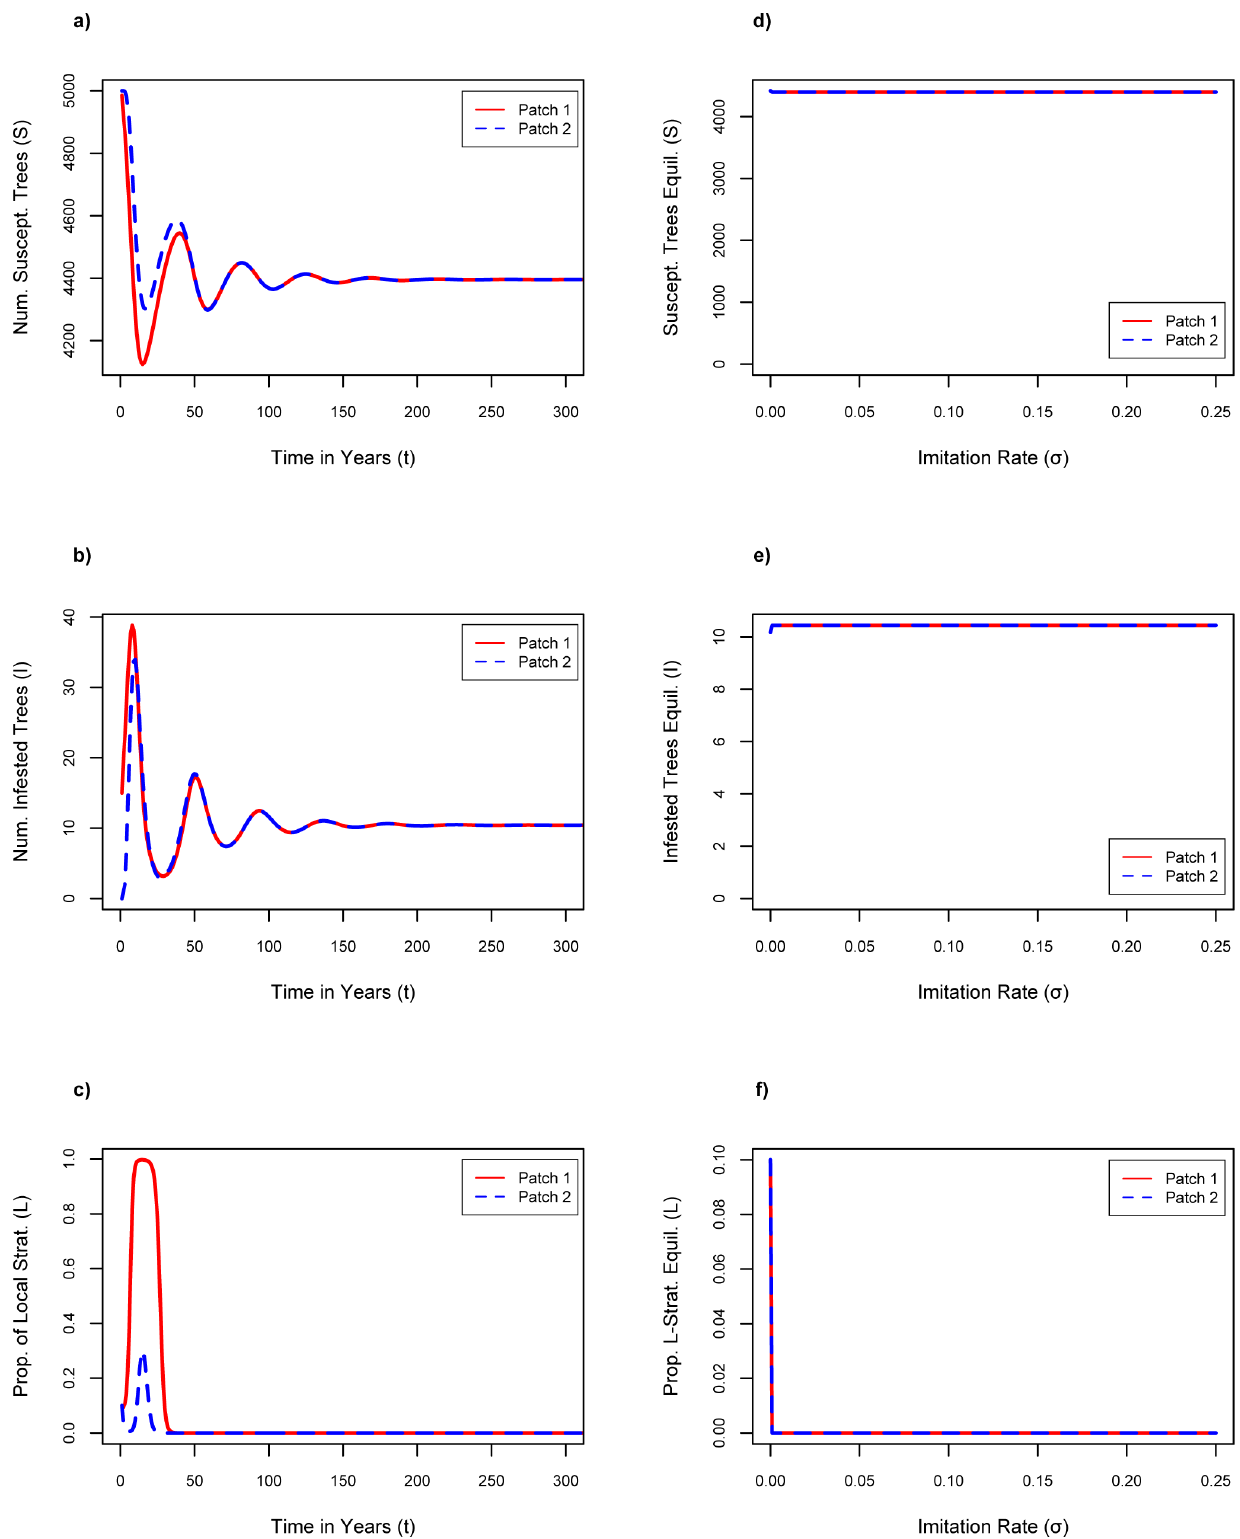
Figure 3. Results of increasing imitation rate. Increase imitation rate: n=0.1, f=0.1, Cl= $ 6.75 where a) number of susceptible trees as a function of time with s =0.5; b) number of infested trees as a function of time with s =0.5; c) proportion of local firewood strategists as a function of time with s =0.5; d) susceptible tree equilibria for increasing values of s ; e) infested tree equilibria for increasing values of s ; f) proportion of local firewood strategist equilibria for increasing values of s .